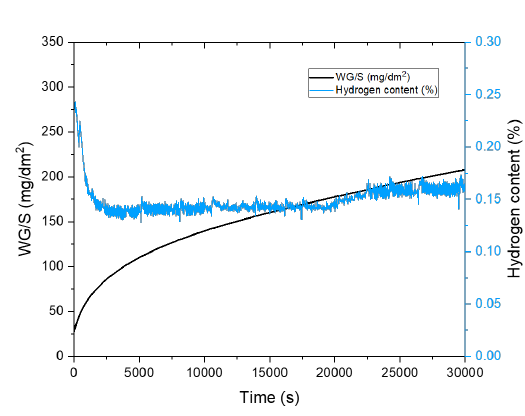
Figure 6. Hydrogen content in time during the isothermal experiment at the temperature of 1200